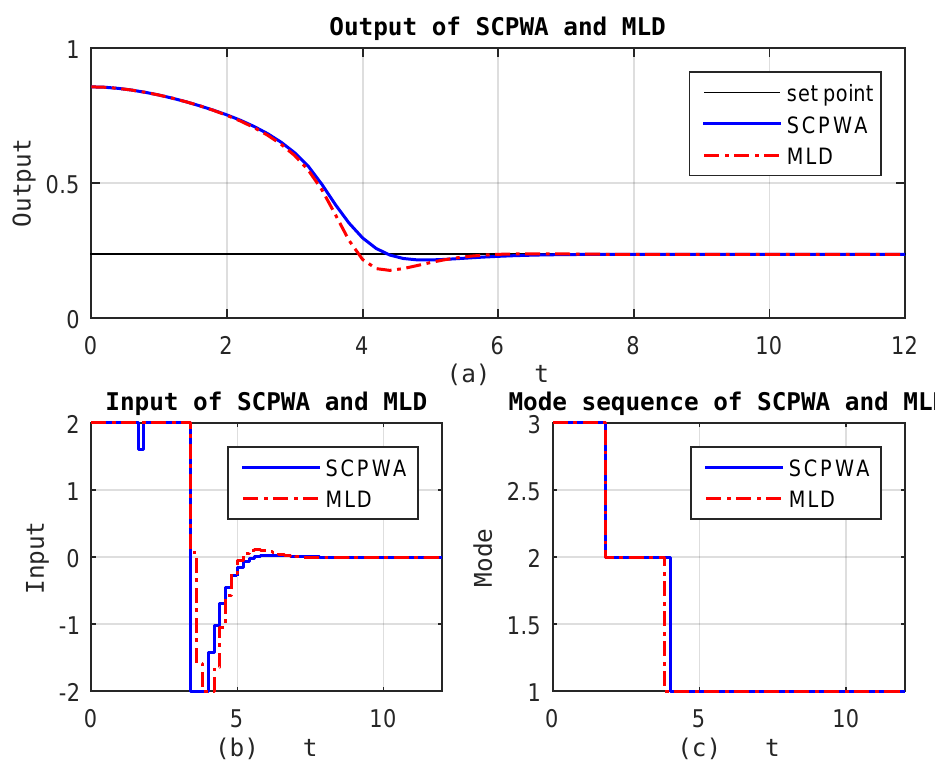
Figure 3. Trajectories of output, input and mode of mixed logical dynamic (MLD) and semi-continuous piecewise a ffi ne (SCPWA)-based MPC, respectively, in case study 1 of the operating point to operating